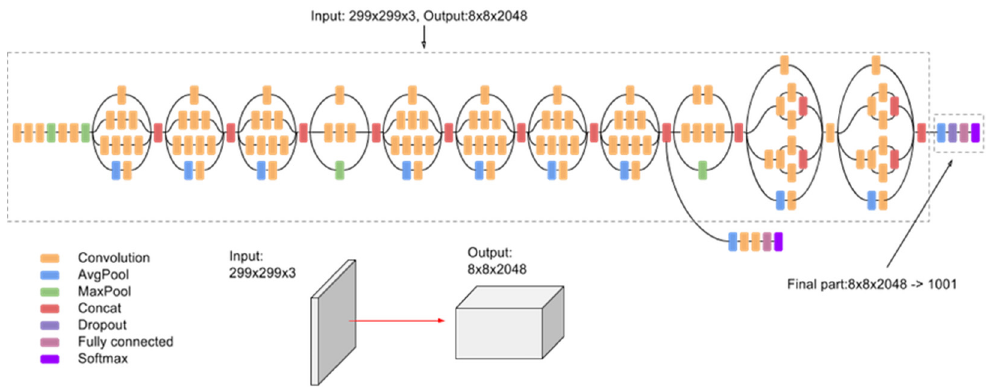
Figure 15. InceptionV3 CNN model architecture.